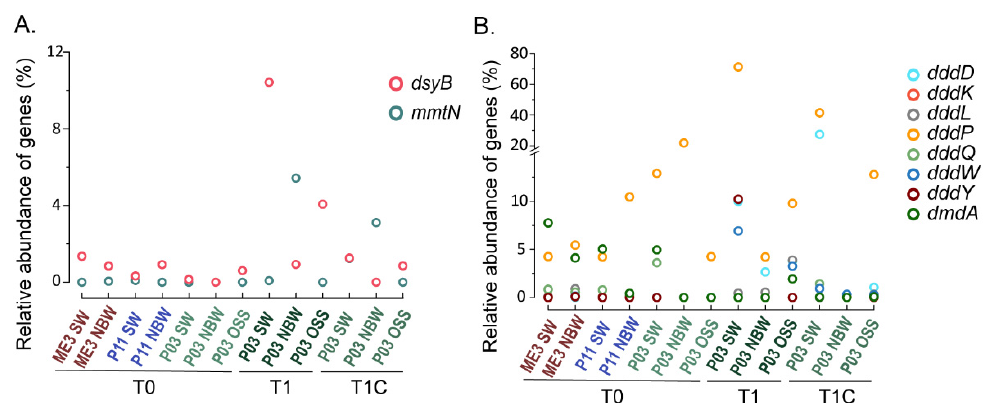
Figure 6. Relative abundance of DMSP cycling genes revealed by metagenomic data of natural samples (T0), and from control (T1C) and enriched (T1) incubation experiments of P03 after 14 days. ( A ) The relative abundance of DMSP biosynthesis genes. ( B ) The relative abundance of DMSP degradation genes. SW: surface water; NBW, near bottom water; OSS, oxic surface sediment. No phytoplankton DSYB and TpMMT gene sequences were detected in the